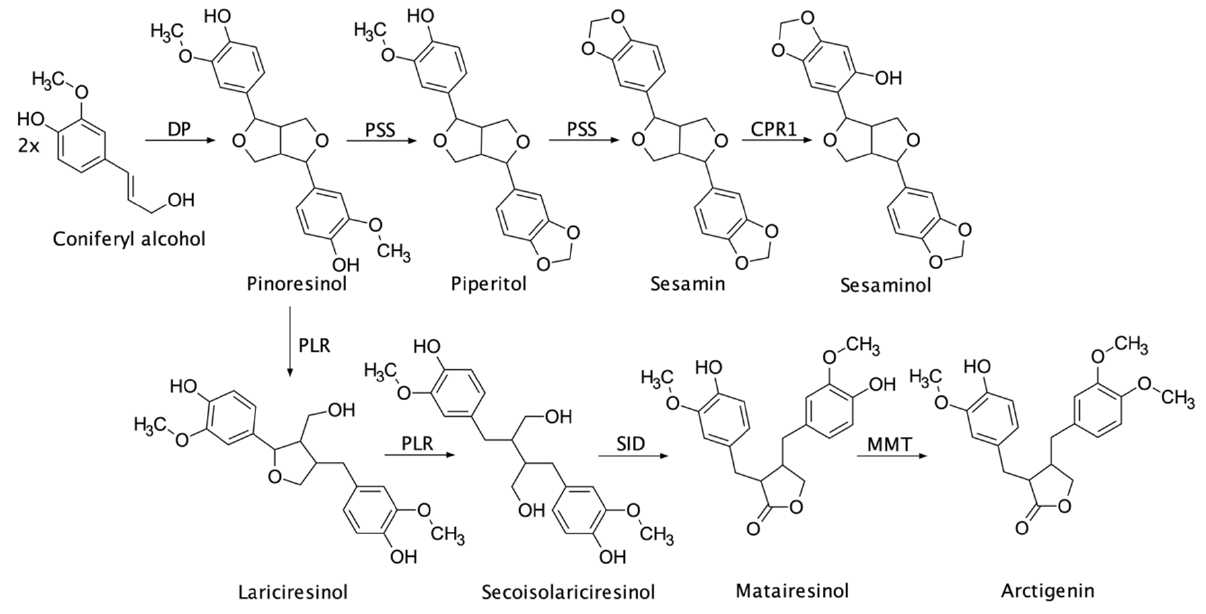
Figure 1. Biosynthetic pathway of major lignans reconstructed from the published records [1,4–11]. DP (dirigent protein), PSS (piperitol/sesamin Synthase), PLR (pinoresinol/lariciresinol reductase), CPR1 (cytochrome P450 oxidoreductase 1), SID (secoisolariciresinol dehydrogenase), MMT (matairesinol O-methyltransferase).